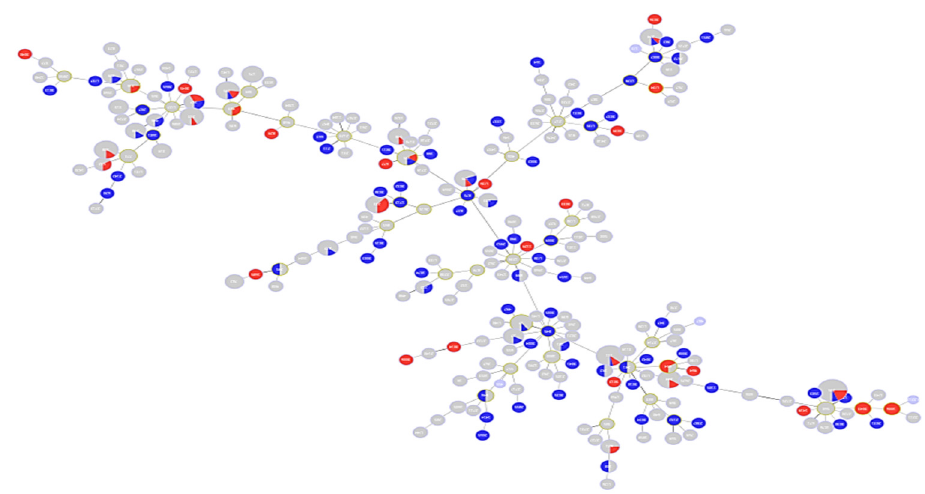
Figure 8. MST diagram showing distribution of gentamycin susceptibility in relation to different STs. Red color: gentamycin resistant ( n = 57); blue color: gentamycin susceptible ( n = 82); grey color: unknown susceptibility to gentamycin.